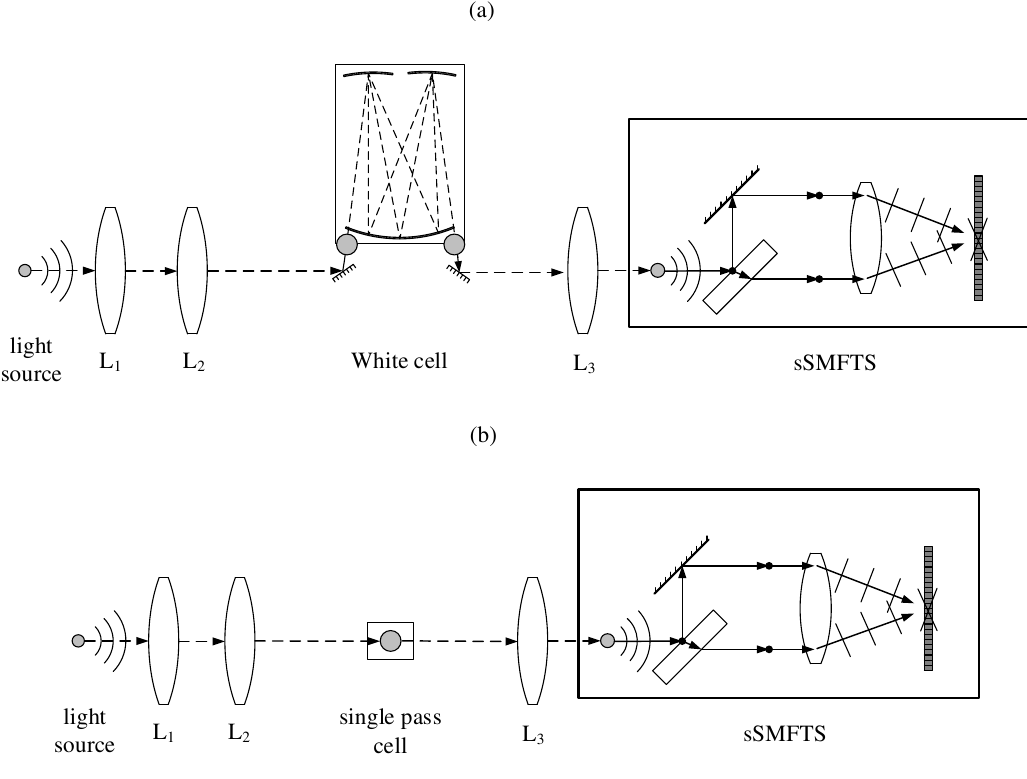
Figure 3. ( a ) Measurement setup containing a customized White cell for sensitive quantitative gas analysis; ( b ) Measurement setup containing a single pass cell for high-speed qualitative gas measurement